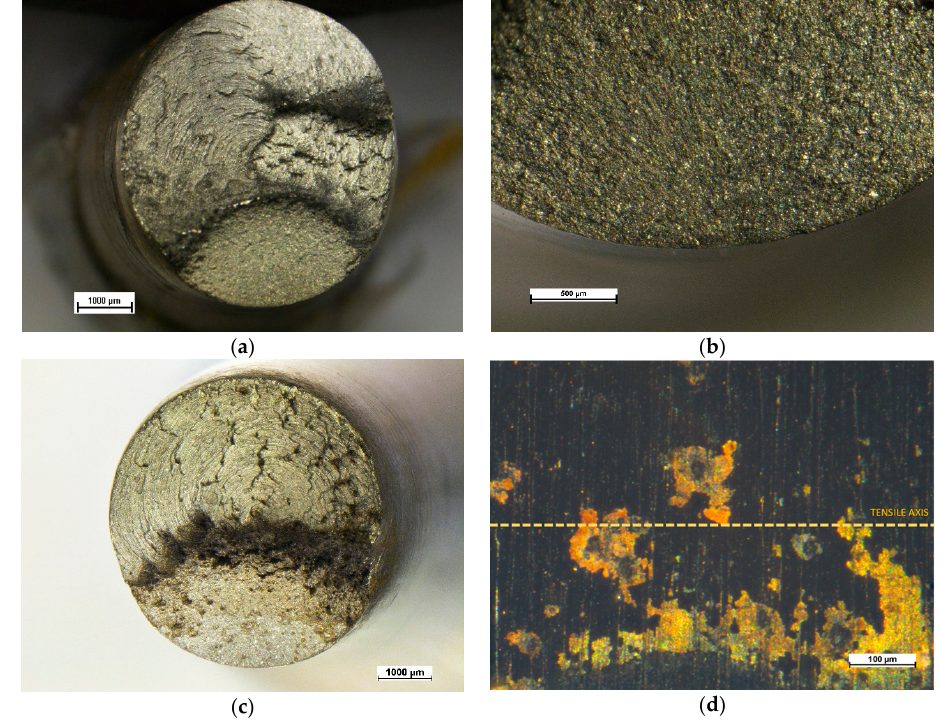
Figure 10. Optical images of the fracture surface of a welded AISI304—ASTM A105 specimen tested to fatigue corrosion (FC): ( a ) Top view of the sample fracture surface tested at 450 MPa; ( b ) close-up of the fatigue fracture surface and crack nucleation area of the sample ( a ); ( c ) top view of the sample fracture surface tested at 450 MPa; ( d ) external surface of the sample in ( c ) near the fracture surface.